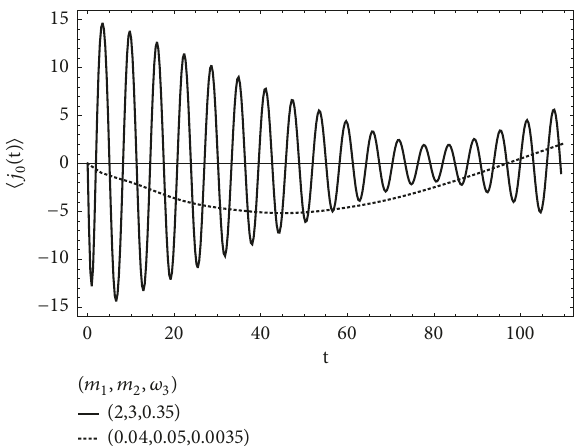
Figure 9: Comparison between two different periods of the time evolution of the PNA. We use the dimensionless time 𝑡 = 𝜔 푟 3, 0 (𝑥 0 − 𝑡 ) for horizontal axis and as a reference we choose 𝜔 푟 = 0 3, 0 ) = (100,10 −3 ) for all the lines. 0.35 . We fix parameters (𝑇,𝐻 푡 0 The black (shorter period) and black dotted (longer period) lines show the set parameters ( ̃𝑚 1 , ̃𝑚 2 , 𝐵,𝜔 3, 0 ) as ( 2,3,1.58, 0.35 ) and ( 0.04,0.05,0.021,0.0035 ), respectively. Notice that our approxima- tion will break down after 𝑡 = 80 .